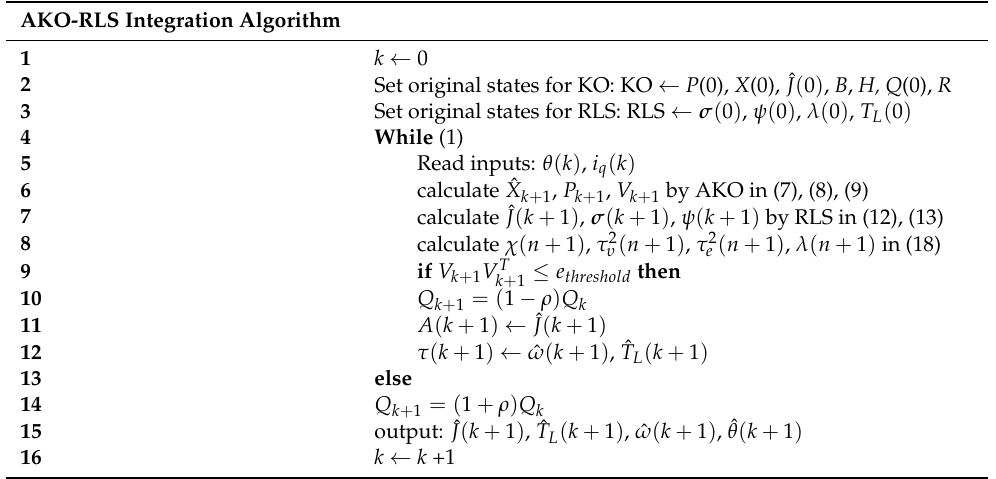
Table 2. The AKO-RLS